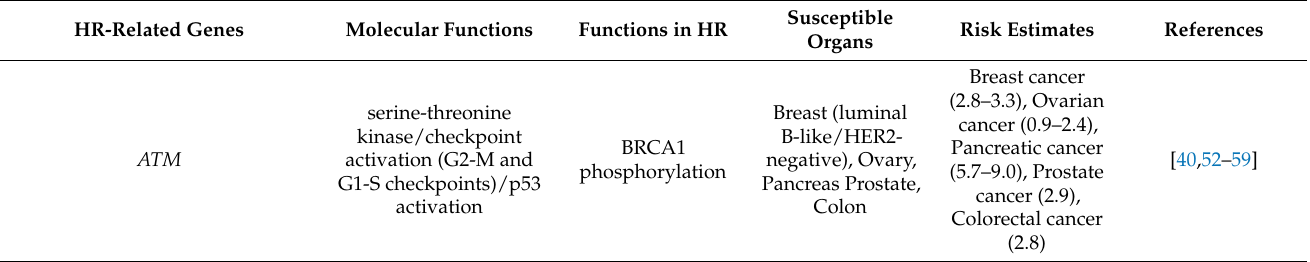
Table 1. Representative HR-related genes, functions, and susceptibility to cancer types due to germline